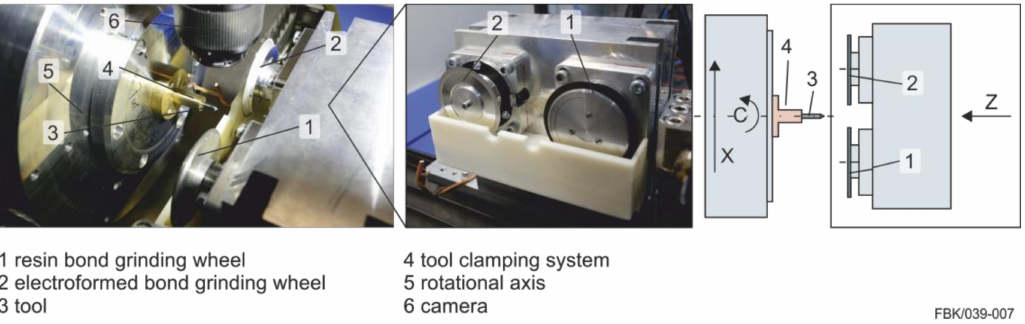
Figure 2. LT-Ultra MTC 250 1 rebuilt for micro end mill manufacture.